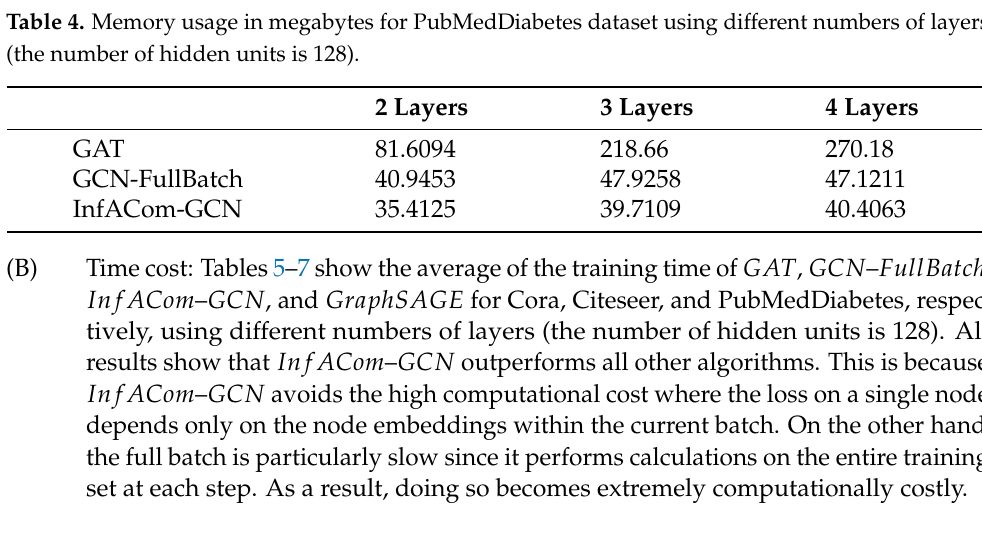
Table 5. Average time of 50 epochs for Cora dataset using 2, 3, and 4 layers (the number of hidden units is 128).